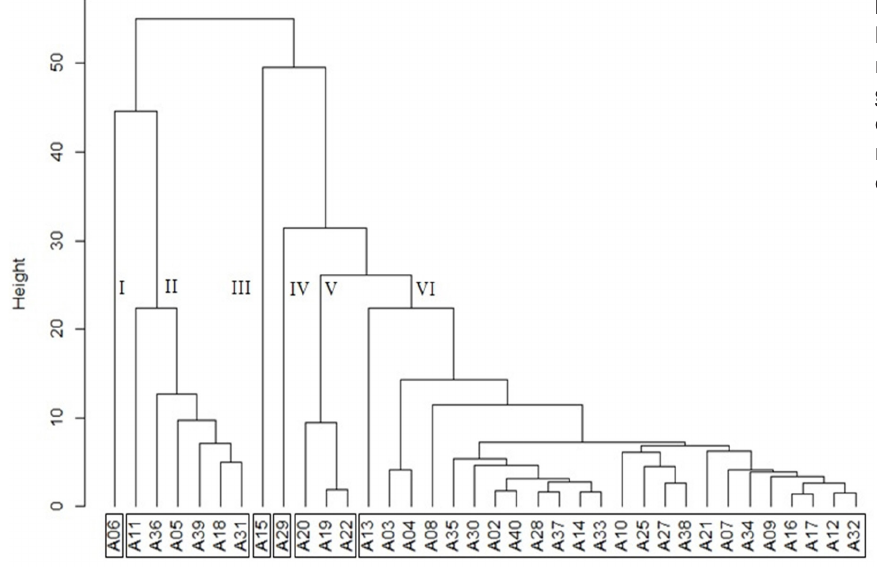
Figure 2. Cluster analysis based on the essential oil main constituents of 36 genotypes of E. uniflora , obtained by the UPGMA method. Cophenetic correlation =